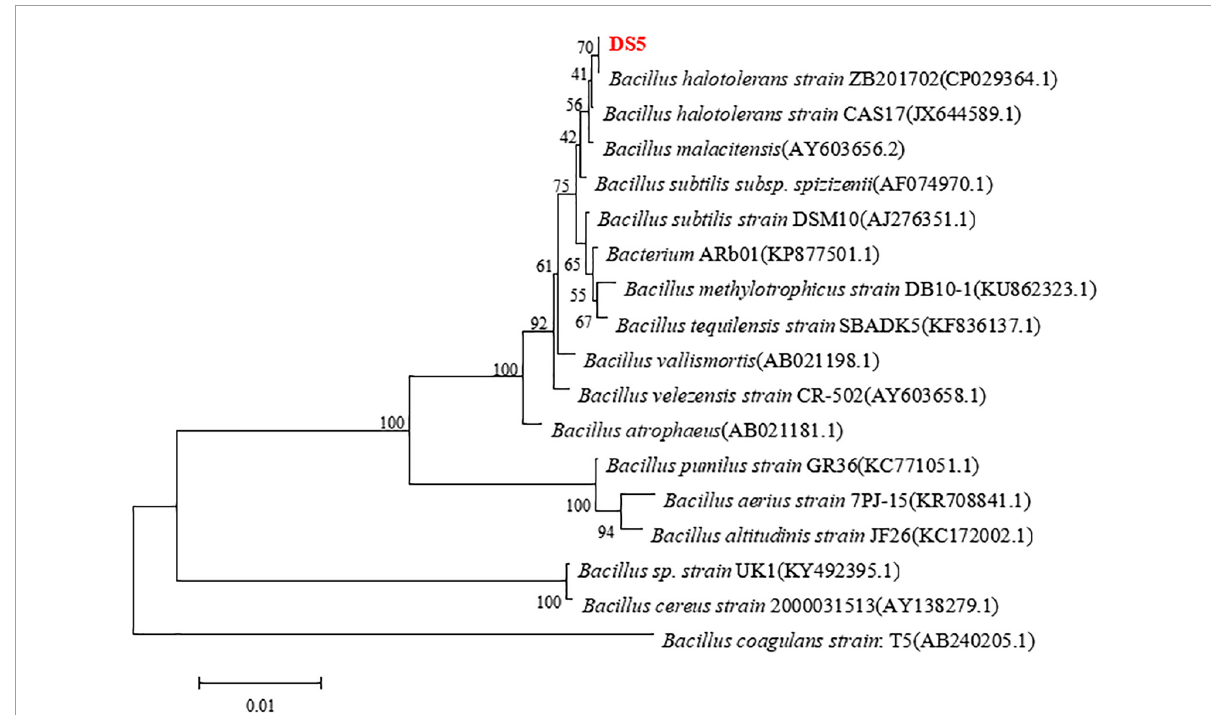
FIGURE2 Phylogenetic tree analysis of Bacillus halotolerans DS5 . Bootstrap values (expressed as percentages of 1,000 replications) are listed at branching points. The scale bar represented 1% divergence. The strains of each genome are as follows: Bacillus halotolerans strain ZB201702 (GenBank: CP029364.1), Bacillus halotolerans strain CAS17 (GenBank: JX644589.1), Bacillus malacitensis (GenBank: AY603656.2), Bacillus subtilis subsp. spizizenii (GenBank: AF074970.1), Bacillus subtilis strain DSM 10 (GenBank: AJ276351.1), Bacterium ARb01 (GenBank: KP877501.1), Bacillus methylotrophicus strain DB10-1 (GenBank: KU862323.1), Bacillus tequilensis strain SBADK5 (GenBank: KF836137.1), Bacillus vallismortis (GenBank: AB021198.1), Bacillus velezensis strain CR-502 (GenBank: AY603658.1), Bacillus atrophaeus (GenBank: AB021181.1), Bacillus pumilus strain GR36 (GenBank: KC771051.1), Bacillus aerius strain 7PJ-15 (GenBank: KR708841.1), Bacillus altitudinis strain JF26 (GenBank: KC172002.1), Bacillus sp. strain UK1 (GenBank:KY492395.1), Bacillus cereus strain 2000031513 (GenBank: AY138279.1), and Bacillus coagulans strain:T5 (GenBank: